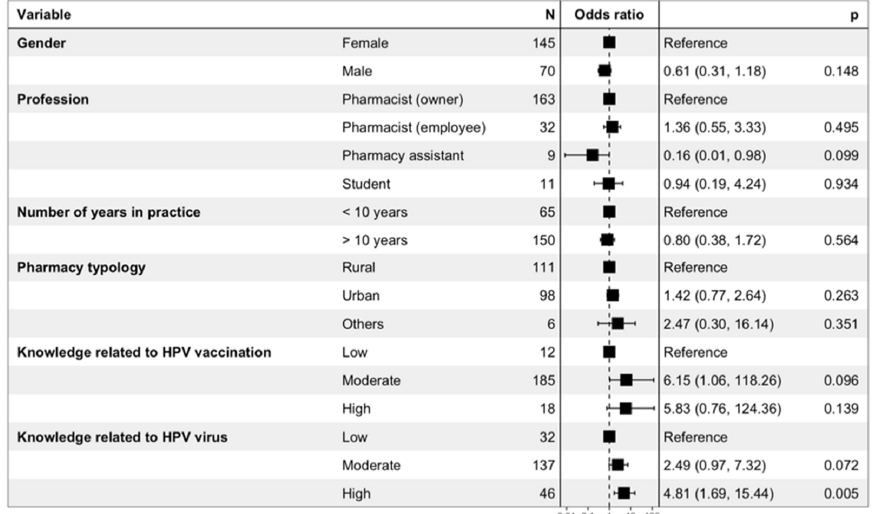
Figure 8. Binary logistic regression performed to evaluate the determinants of the right attitude toward HPV vaccination in boys. The right attitude toward HPV vaccination in boys corresponded to respondents that (i) found HPV vaccine useful for boys, (ii) con ‐ sidered that HPV vaccine was safe for boys, and (iii) had previously advised HPV vac ‐ cination to an 11–14 ‐ year ‐ old boy.